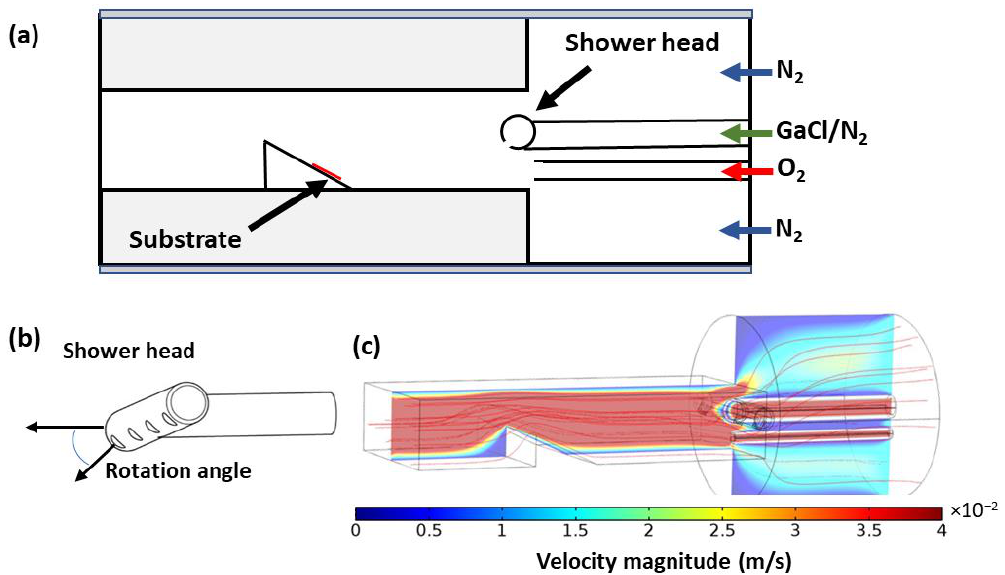
Figure 1. ( a ) Schematic drawing of the simulated part of the reactor with a shower head inlet for GaCl. ( b ) The shower head with possible rotation angles of its outlets relative to the horizontal axis. ( c ) The reactor flow geometry with an example of a 3D simulation of the gas velocity and streamlines for the velocity field inside the reactor using a shower head with a rotation angle of 60 degrees.